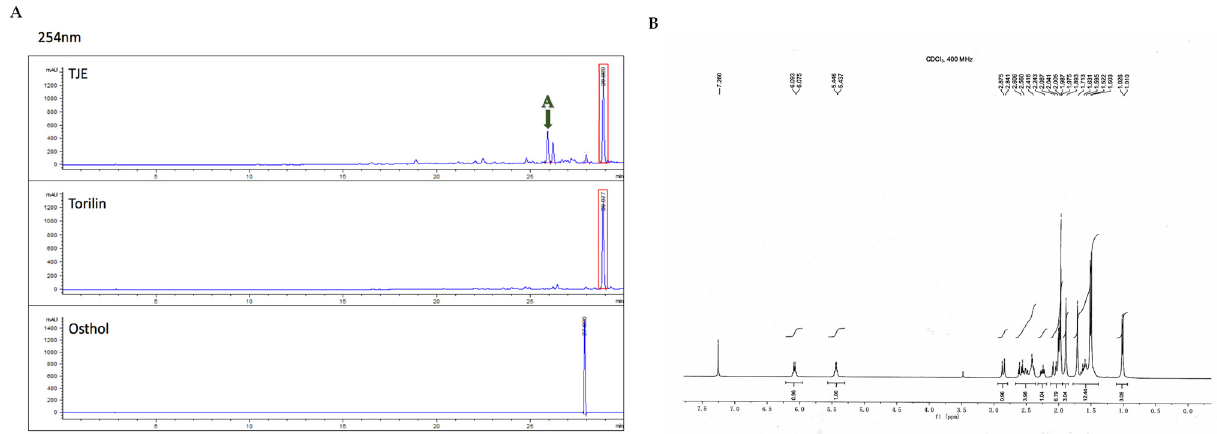
Figure 1. ( A ) HPLC profile of TJE, torilin, and osthol. Torilin was detected, but osthol was not de- tected in TJE (A: the unknown substance). ( B ) NMR profile of the unknown peak (substance) A.